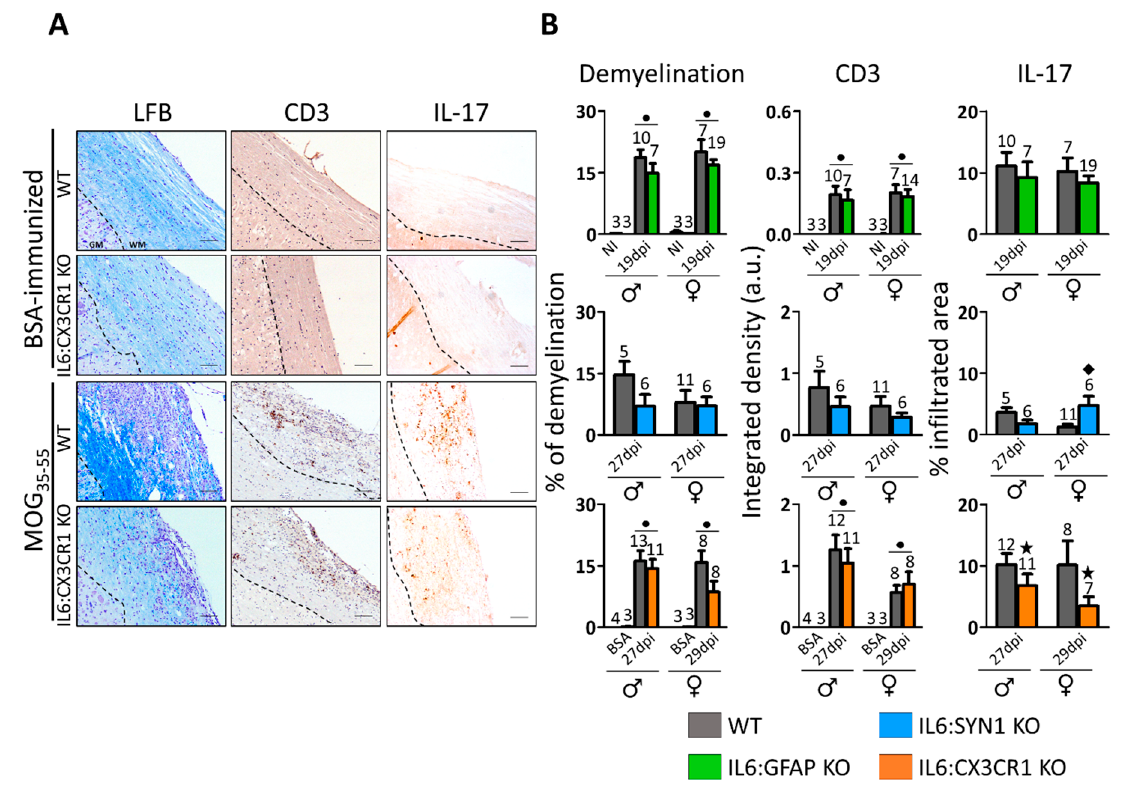
Figure 3. Analysis of demyelination and infiltrates in the white matter of CNS. ( A ) Representative images of LFB staining counterstained with hematoxylin ( left ), CD3 immunostaining counterstained with hematoxylin ( middle ), and Interleukin-17 (IL-17) ( right ) immunostaining of bovine serum albumin (BSA)- and MOG 35–55 -immunized mice. The discontinuous line delimits white matter (WM) from gray matter (GM). MOG 35–55 immunization caused clear signs of demyelination and prominent accumulation of inflammatory cellular infiltrates. Scale bar: 100 µ m. ( B ) Quantification of LFB staining ( left ), CD3 + ( middle ), and IL-17 + ( right ). BSA- and non-immunized (NI) mice had no demyelination or infiltrates in comparison with MOG 35–55 -imunized animals. No significant di ff erences between genotypes were observed other than the decrease of IL-17 IHC in IL6:CX3CR1 KO mice and a sex-dependent opposed e ff ect in IL6:SYN1 KO mice. All results were normalized per total area and represented in MEAN ± SEM. Number of mice per group as indicated. • p ≤ 0.05 versus BSA / NI mice (cid:70) p ≤ 0.05 versus WT mice. (cid:7) Indicates a significant interaction between genotype and sex.